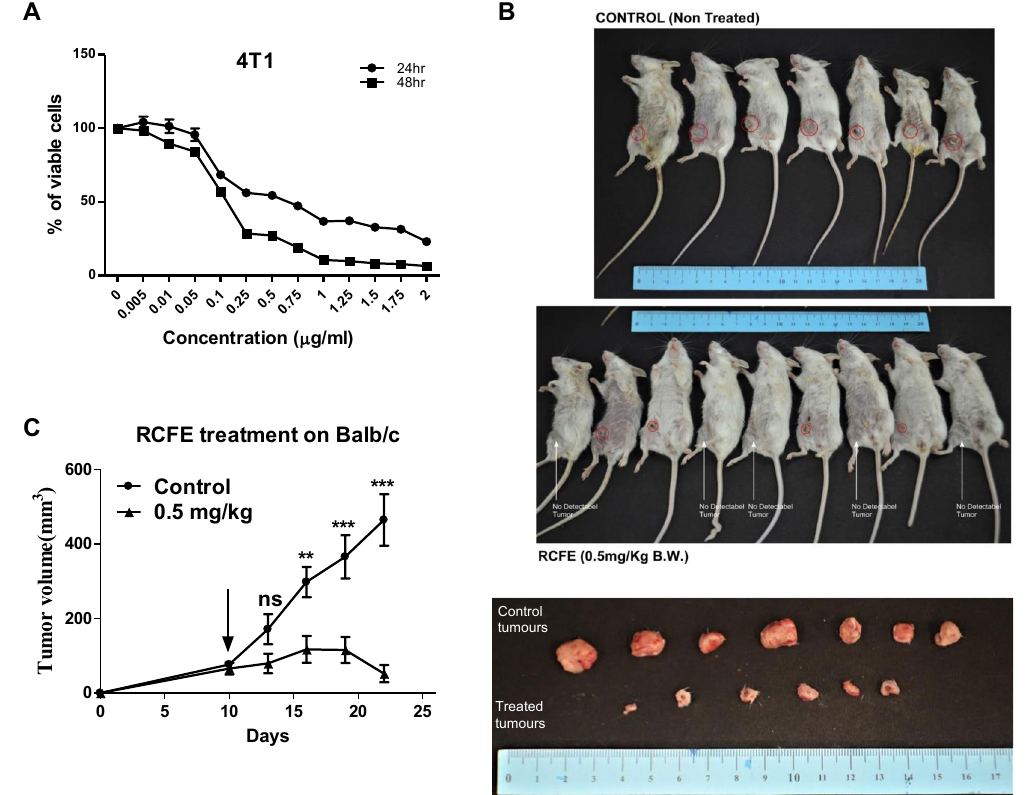
Figure 5. RCFE inhibited tumor progression: ( A ) 4T1 cells were treated with various concentrations of RCFE for 24 and 48 hr. Data represent the mean ± SEM of three independent experiments. ( B ) The animals treated with 0.9% normal saline (upper panel) and RCFE at 0.5 mg/kg bodyweight (middle panel). Animals with visible tumor from outside was pointed with red circles. Animals with no visible tumors from outside was shown by white arrows. The excised tumors from control and RCFE-treated animals (bottom panel). ( C ) Graph represented the measured tumor volumes in two different treatments. Statistical differences were analyzed with two-way ANOVA test. p value ns > 0.05, p value *** <